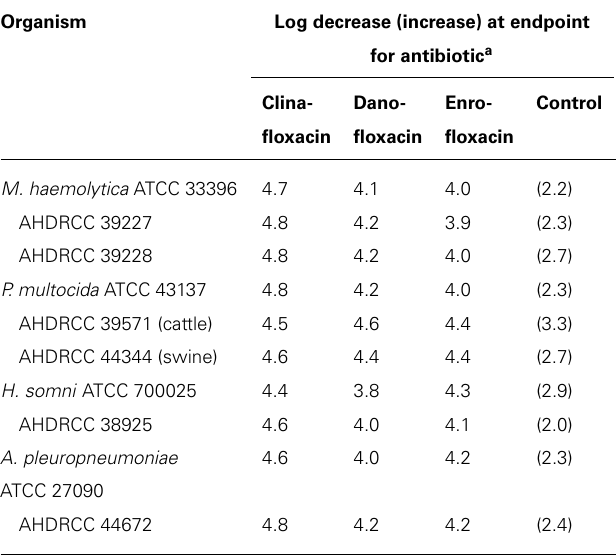
Table 2 |Time-kill results for clinafloxacin and comparator drugs tested at four times the MIC. Organism Log decrease (increase) at endpoint